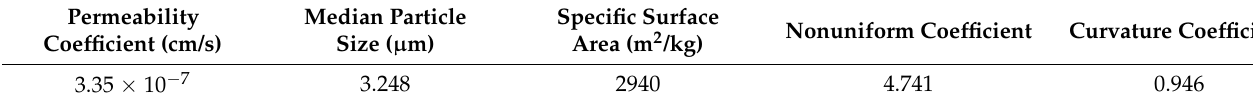
Figure 1. Laboratory test process of RCB. Table 1. Physical properties of BRM.